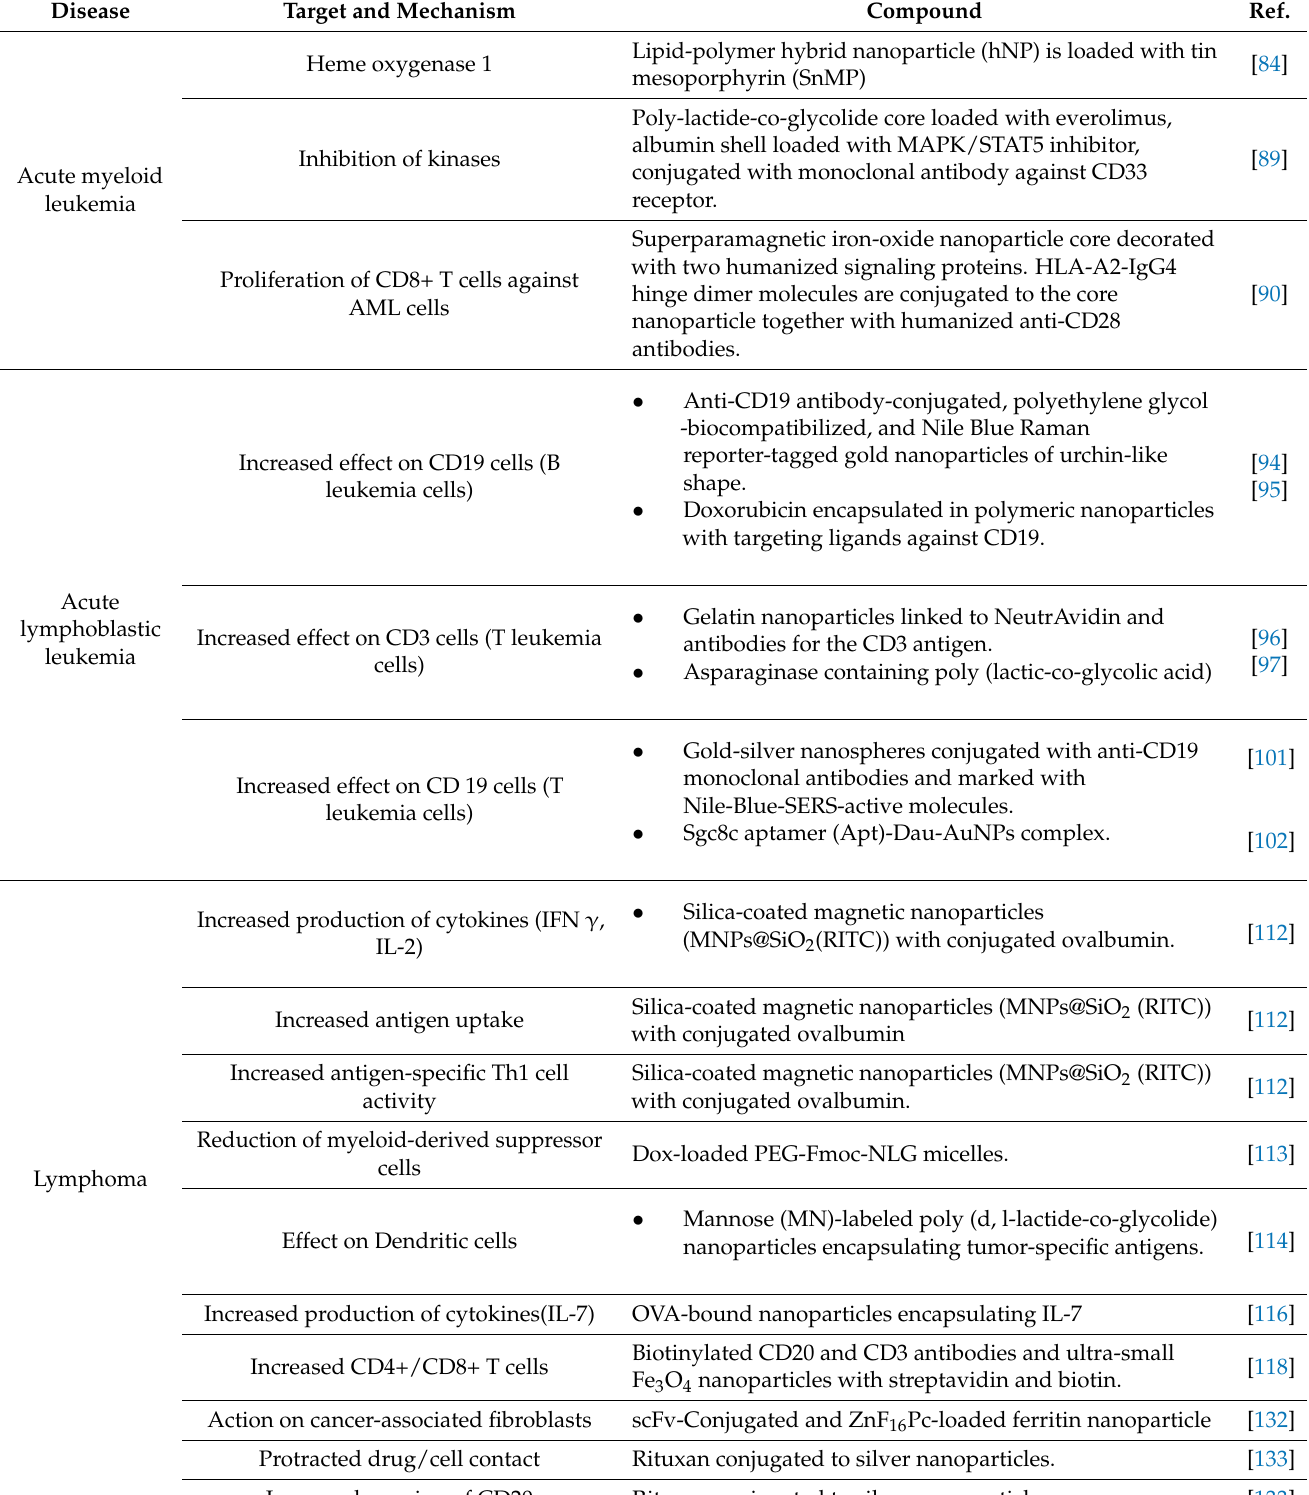
Table 2. Effects of nanoparticles on the efficacy of immunotherapeutic treatment of hematological neoplasms.